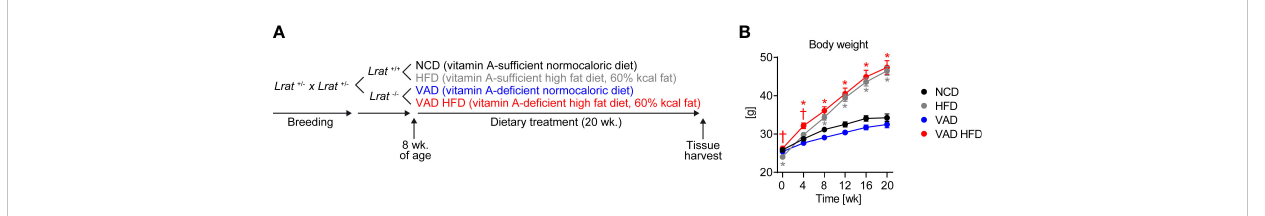
FIGURE 1 Experimental paradigm and increase in body weight independent of VitA following HFD feeding. (A) Mice with homozygous Lrat germline deletion ( Lrat -/- ) and wildtype controls ( Lrat +/+ ) were obtained by breeding mice with heterozygous Lrat germline deletion ( Lrat +/- ). Dietary treatment started at 8 weeks of age for a duration of 20 weeks total. (B) Body weight data are reported as mean values ± SE and represent a subgroup of a previously published animal cohort (14). Two-way ANOVA was performed to analyze differences by HFD feeding and VitA. Results of post-hoc analyses for each comparison are summarized by symbols as de fi ned: # p<0.05 for HFD feeding, $ p<0.05 for VitA, and & p<0.05 for the interaction between HFD feeding and VitA. Body weight following 0 ($, &), 4 (#, &), 8 (#, &), 12 (#), 16 (#), and 20 (#) weeks of dietary feeding (n=17-18/group). *p < 0.05 vs. normocaloric diet same VitA availability, † p<0.05 vs. VitA suf fi ciency same caloric